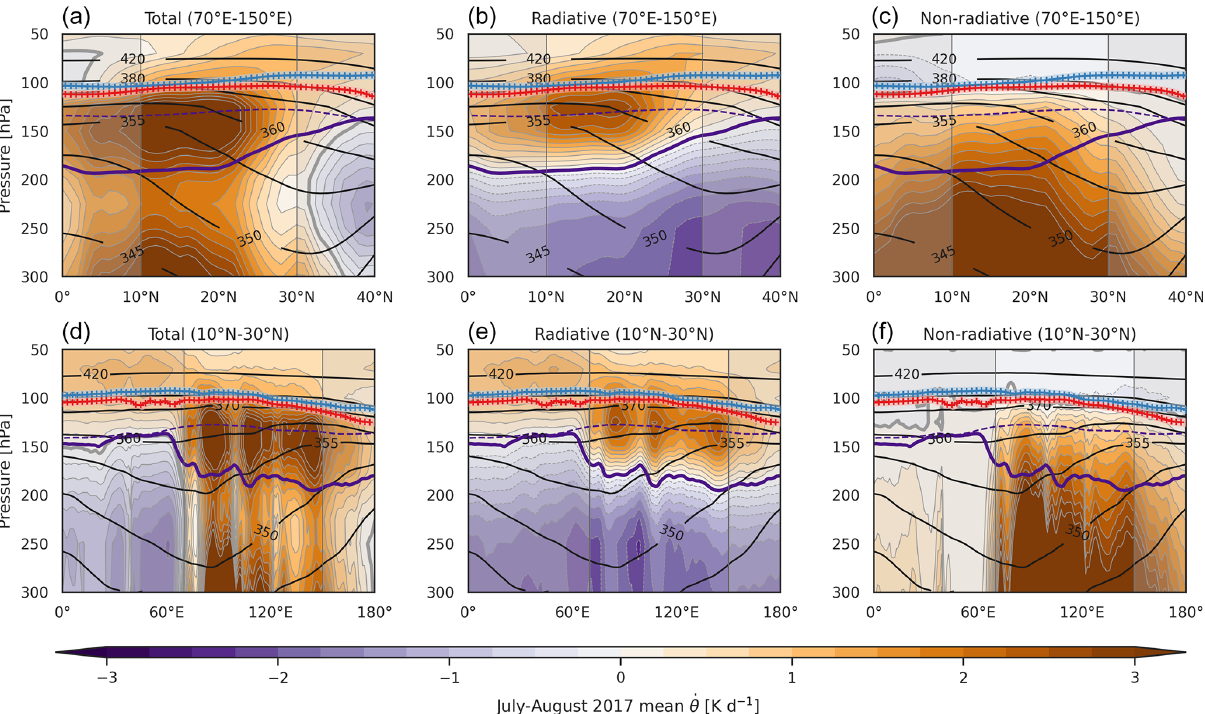
Figure 8. Zonally (a–c) and meridionally (d–f) averaged total (a, d) , radiative (b, e) and non-radiative (c, f) diabatic potential temperature tendencies (d θ/ d t ) diab based on the ERA-Interim reanalysis for July–August 2017. As demarcated by the vertical grey lines and bolder colours on the respective panels, zonal averages are calculated over 70–150 ◦ E and meridional averages over 10–30 ◦ N with area weights applied. Black contours show potential temperature. Purple contours show the vertical location of the LZRH based on the zero contour in time-mean radiative heating rates under all-sky (solid) and clear-sky (dashed) conditions. LRT and CPT are shown in red and blue, respectively. Averaging ranges for θ contours, LZRH, LRT and CPT are the same as those for (d θ/ d t ) diab